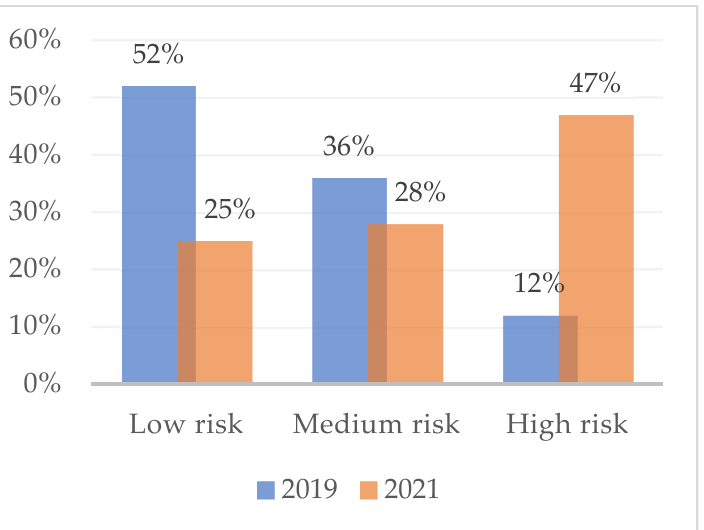
Figure 1. Risk for burnout syndrome due to emotional exhaustion in February 2019 and in April 2021. n = 75.